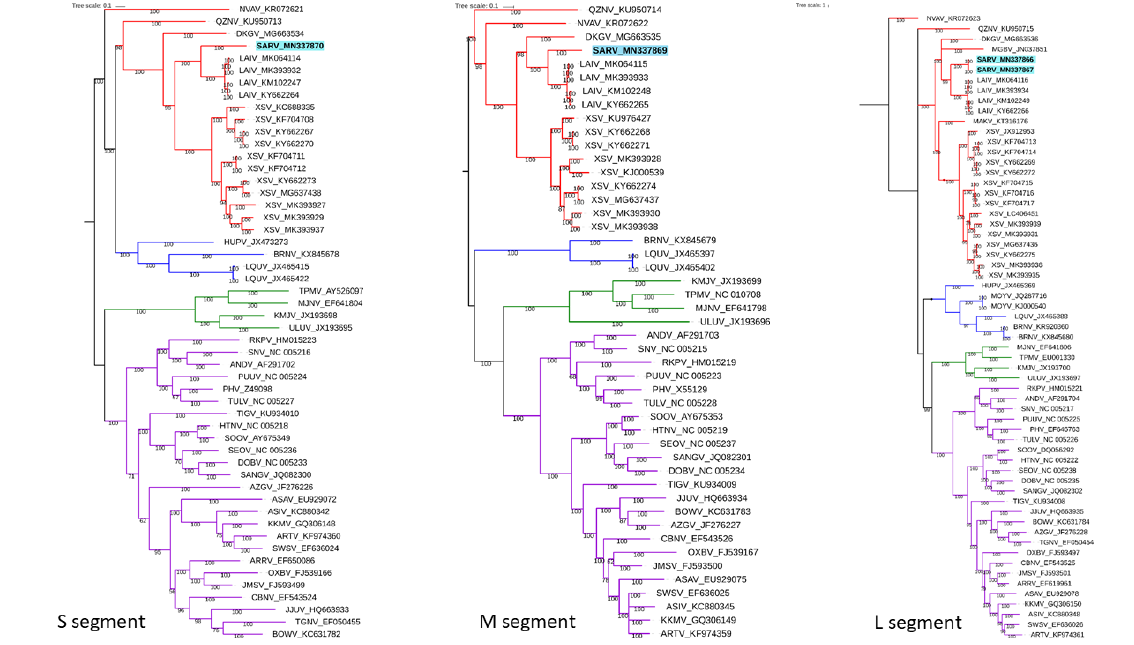
Figure 2. Maximum likelihood analysis of hantavirus S (671 nucleotides), M (1326 nucleotides), and L (383 nucleotides) segments respectively, visualized by the iTol online server. Sarawak mobatvirus reported in this study is highlighted with a blue background and deposited in GenBank under the Accession numbers of MN337866-70. Branch colours for Mobatviruses are highlighted with red, Loanviruses are highlighted with blue, Thottimiviruses are highlighted with green, and Orthohantaviruses are highlighted with